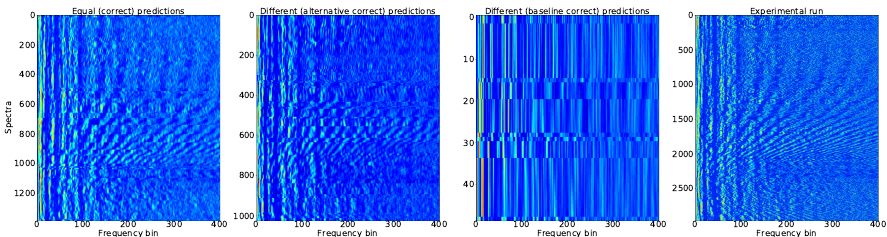
Figure 21. Quadrant analysis for class D (Run # 8) confronting the baseline and all together classifiers in the maximum probability and in the LORO regime. The first panel shows the windows whose both classifiers were right. In the second and third panels, we see the ones where either the GAN-enabled or the baseline classifier obtained the right outputs, respectively. In the fourth panel, the experimental run is shown for